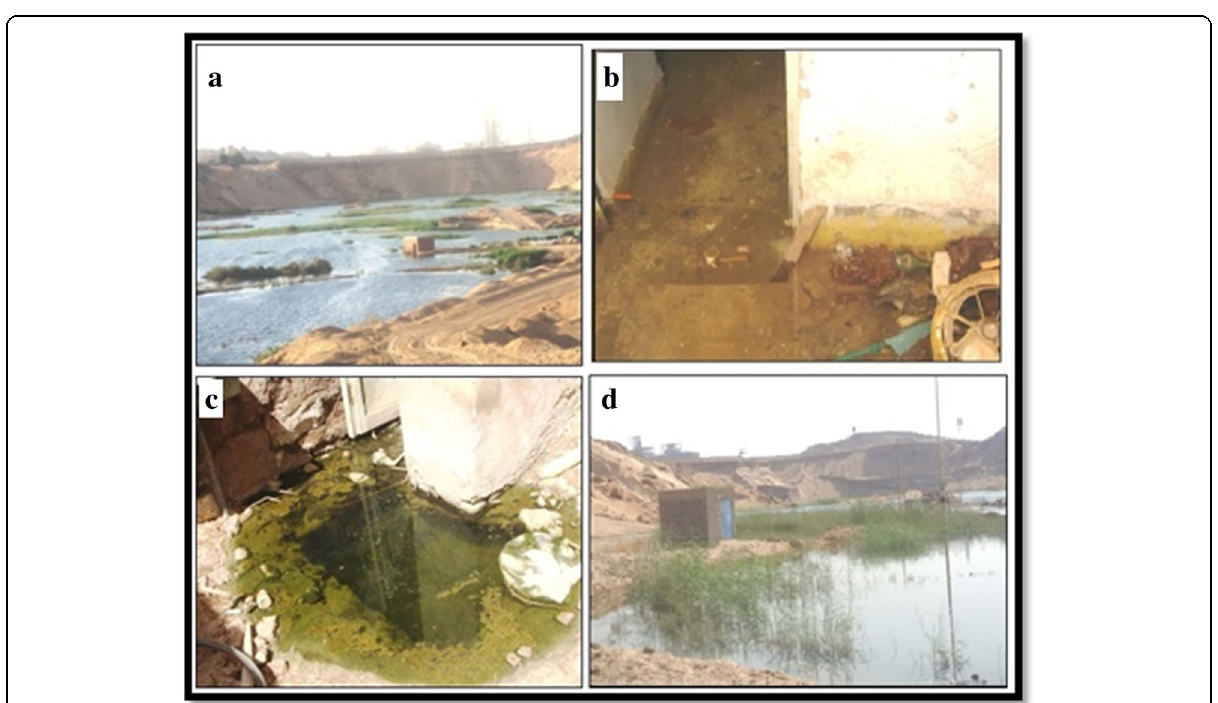
Fig. 16 Rising of the groundwater level a KhorAwada, b , c near some building and d sand quarry in the study